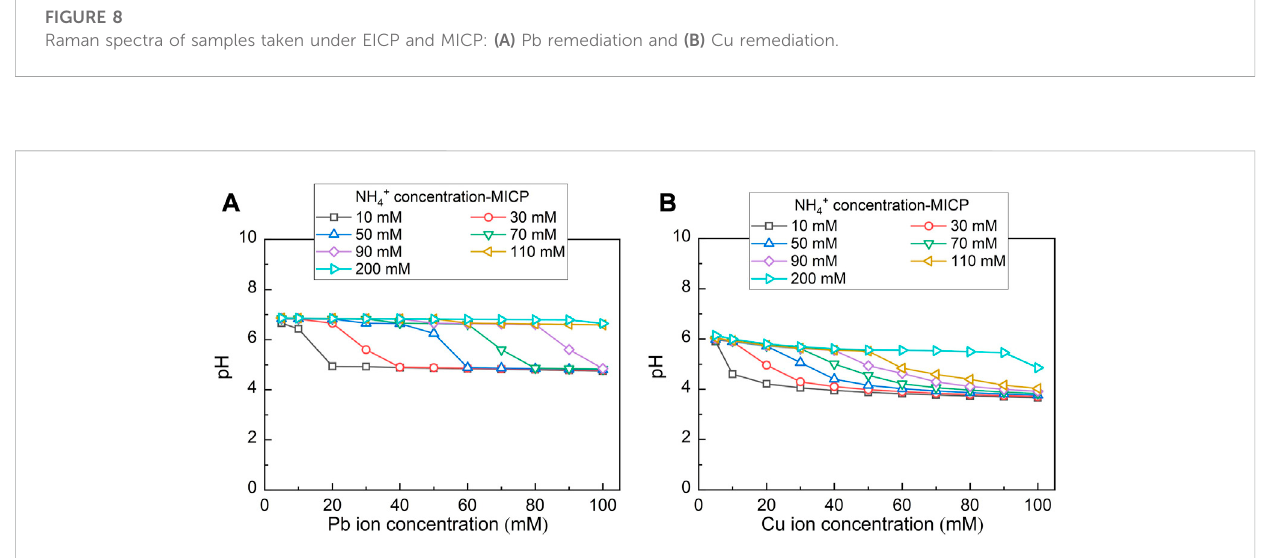
FIGURE 9 (A) Variations of pH surrounding against Pb 2+ concentration under MICP and (B) variations of pH surrounding against Cu 2+ concentration under